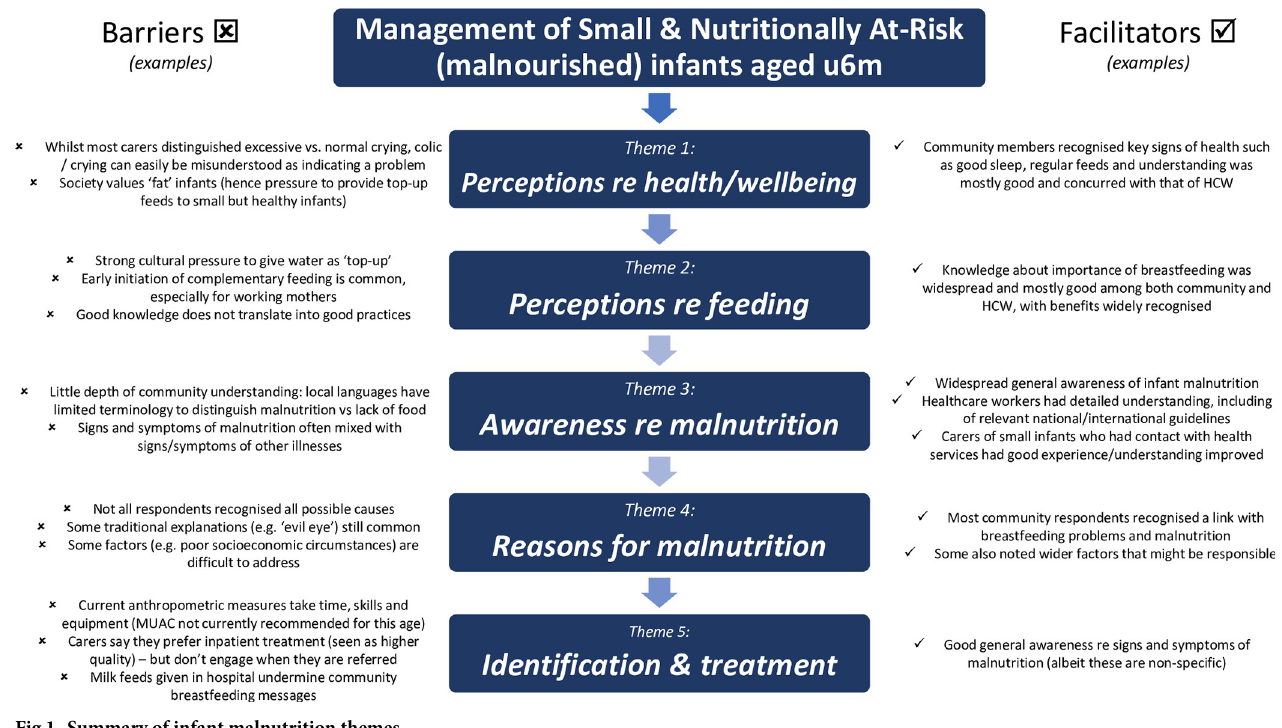
Fig 1. Summary of infant malnutrition